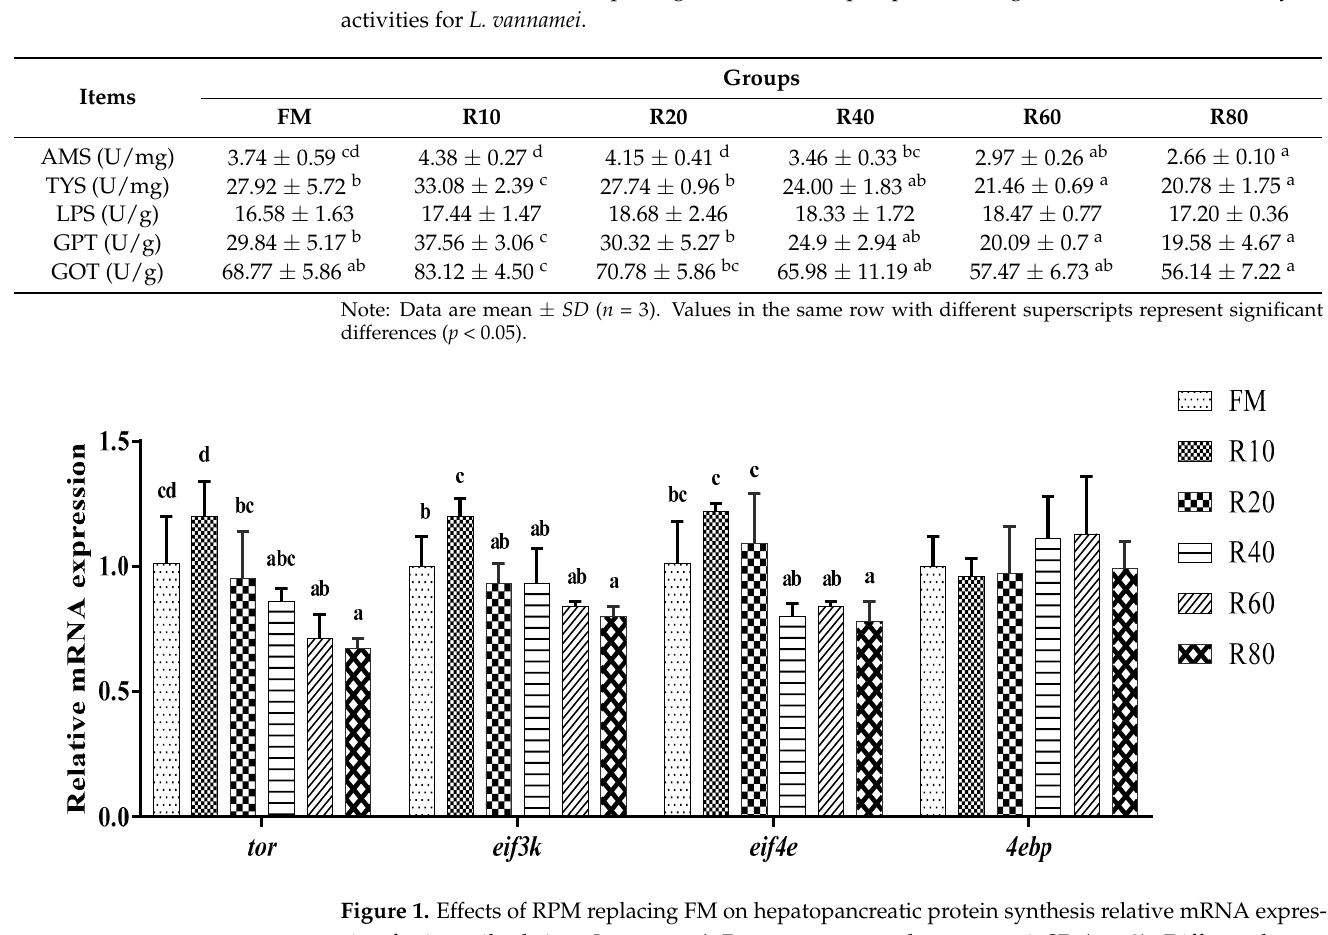
Figure 2. Effects of RPM replacing fishmeal on hepatopancreatic non-specific immune relative mRNA expression for juvenile shrimp L. vannamei . Data are expressed as means ± SD ( n = 3 ). Differ- ent letters above a bar were statistically significant different among treatments ( p < 0.05). 3.8. Effects of RPM on the Intestinal Bacterial Community For diversity indices (Table 9), the coverage of all samples was as high as 0.9987, in- dicating sufficient sequencing depth. The Ace and Chao1 indices were significantly higher